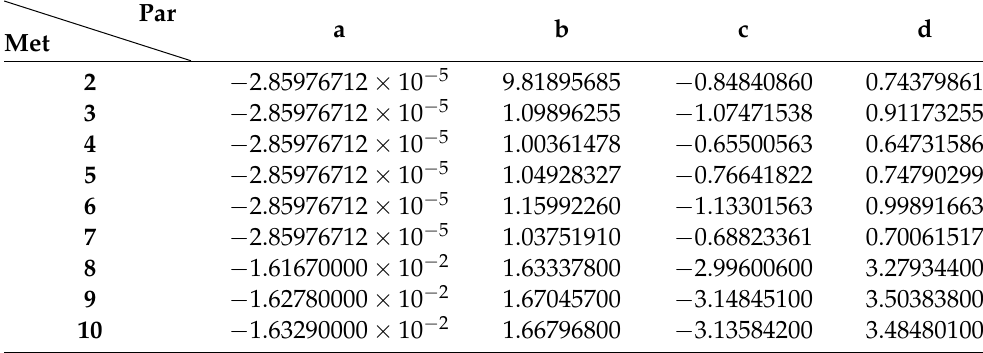
Table 2. Empirical coefficients a–d for the BHR iso conversion used in Equation (1) for each Me- teosat